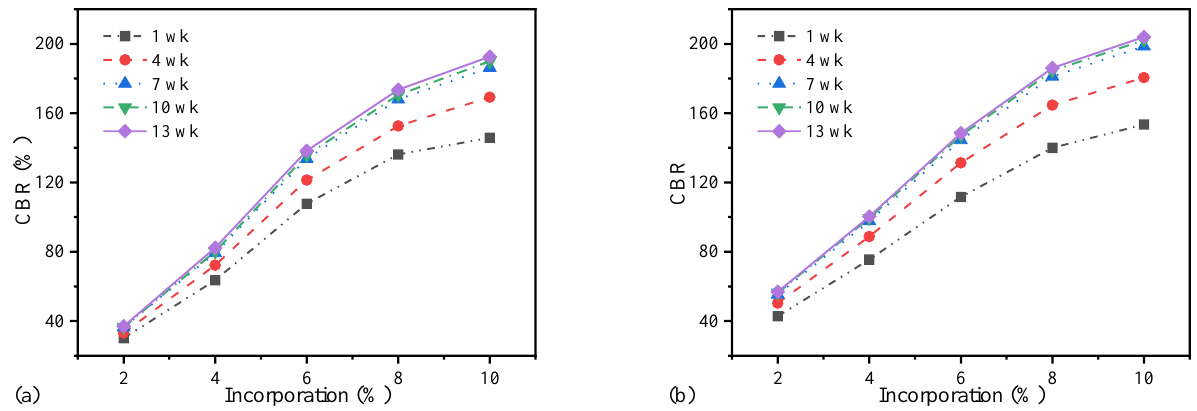
Figure 5. CBR of ( a ) ISW-improved silt and ( b ) cement-improved silt.